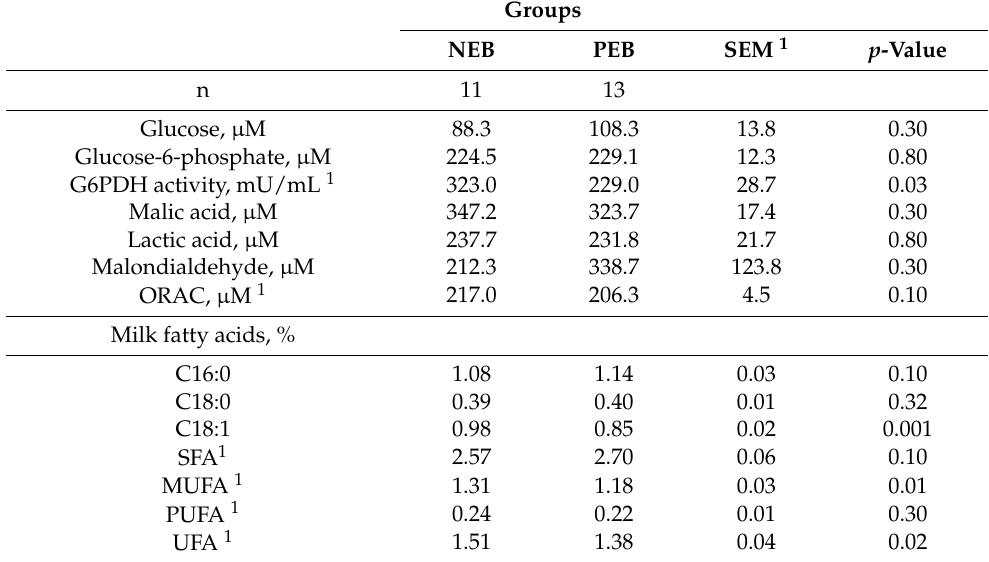
Table 3. The average concentrations of metabolites, oxidative stress markers, and the FA composition in the milk of negative energy balance (NEB) and positive energy balance (PEB) cows during the first 45 d in